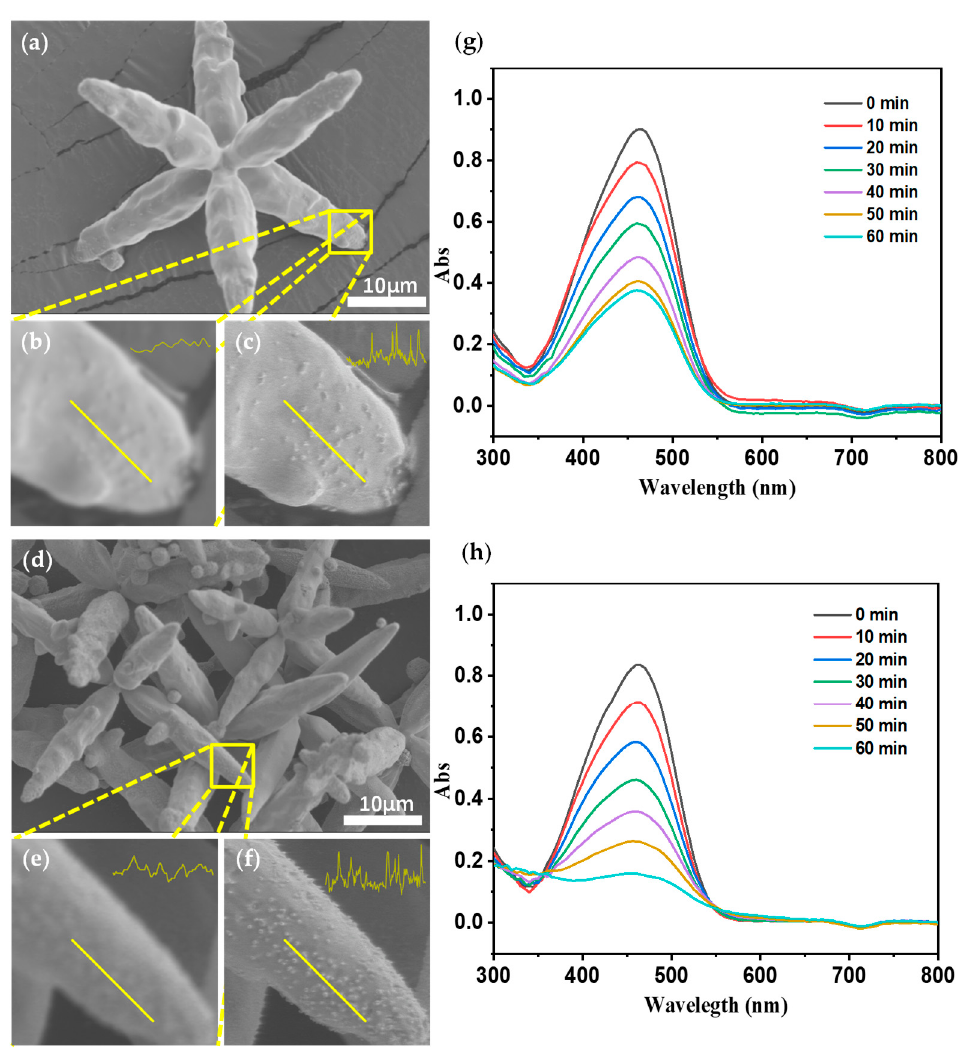
Figure 8. Original SEM image of AgCl@Ag particles with few Ag particles ( a ), zoomed in image of region of interest (ROI) ( b ), super-resolved image of ROI ( c ); original SEM image of AgCl@Ag particles with more Ag particles ( d ), zoomed in image of ROI ( e ), super-resolved image of ROI ( f – h ) UV-Vis spectra of MO under conditions of catalytic degradation of less and more Ag particles, respectively.